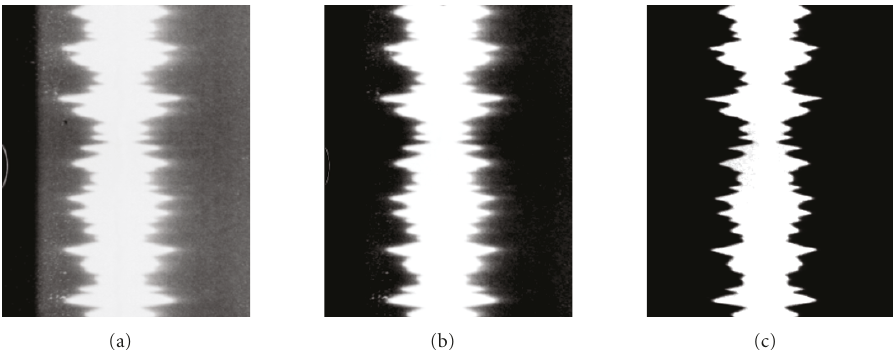
Figure 22: Optical representation of ca. 1/75 second of sound from the “L’acrobate” soundtrack. (a): as grabbed, Middle: histogram stretching at first iteration, between p min and p max , (b): after several iterations according to indicator minimization.